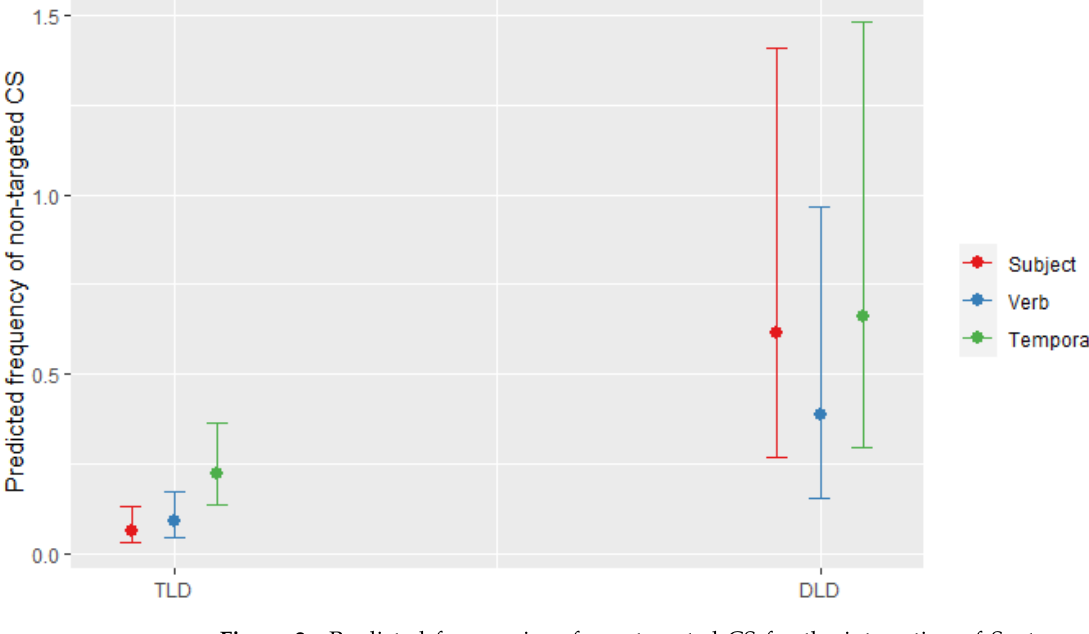
Figure 2. Predicted frequencies of non-targeted CS for the interaction of Sentence constituent and Group.